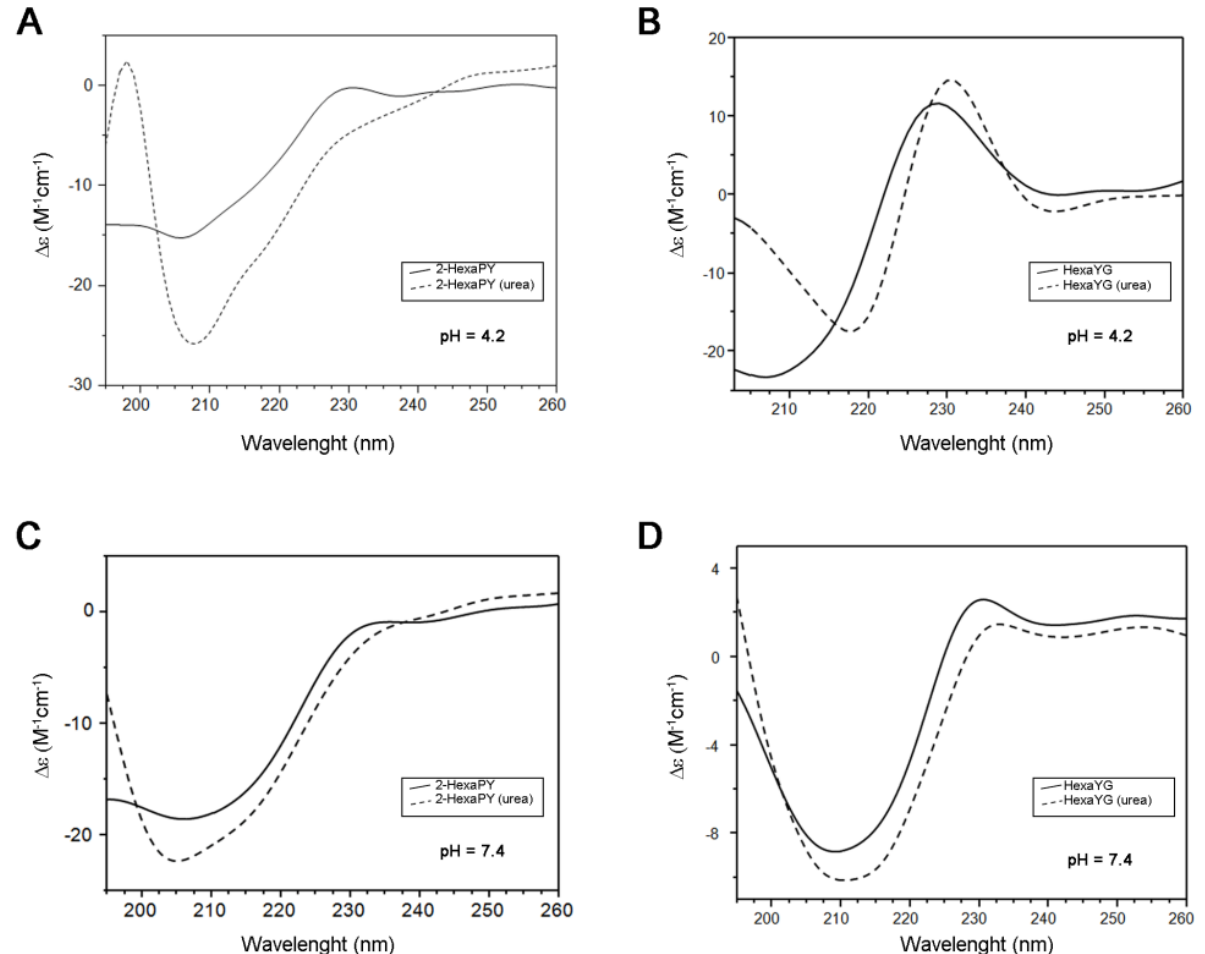
Figure 1. CD spectra of 2-HexaPY ( A , C ) and HexaYG ( B , D ) in H 1 × 10 − 3 M Urea (dotted line). Spectra were recorded at pH 4.2 ( A , B ) and pH 7.4 ( C , D ) for both